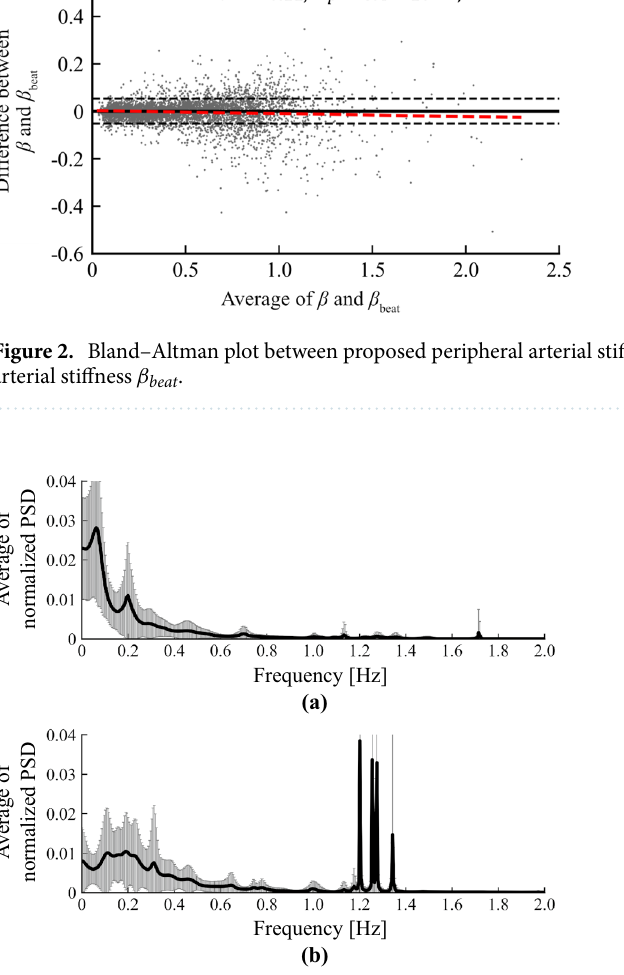
Figure 3. Averages of normalised PSD of peripheral arterial stiffness β for all subjects: ( a ) pre SNB, ( b ) post